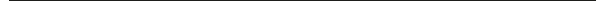
Fig. 4 Chemical, protonic, and electron transport across membrane. a Cyclic voltammograms of pure SiO 2 on Pt/SnO 2 electrode (no wires, red trace) and SiO 2 -encapsulated PV3 on Pt/SnO 2 electrode (correct wires, green trace). Inset: Redox wave of Fe II (CN) 6 / Fe III (CN) 6 with Pt/SnO 2 electrode (bare anode). Scale bar 2.5 mA cm − 2 . These scans